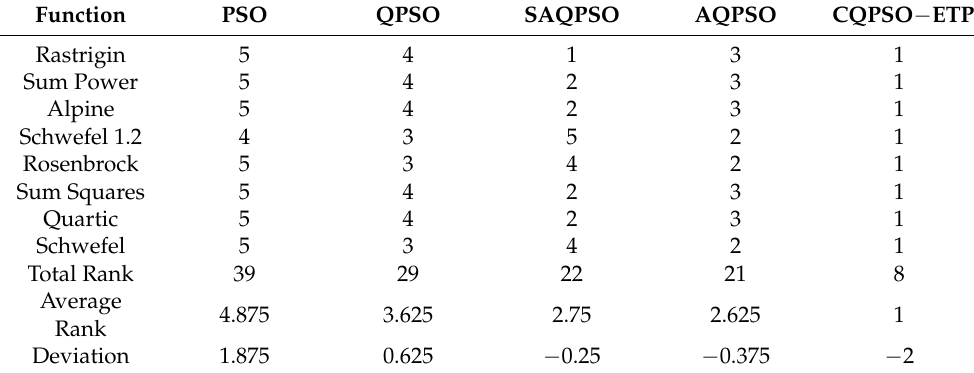
Table 7. Ranks of the average values for five comparative approaches (Mean) and computation of the Friedman test statistic ( D =